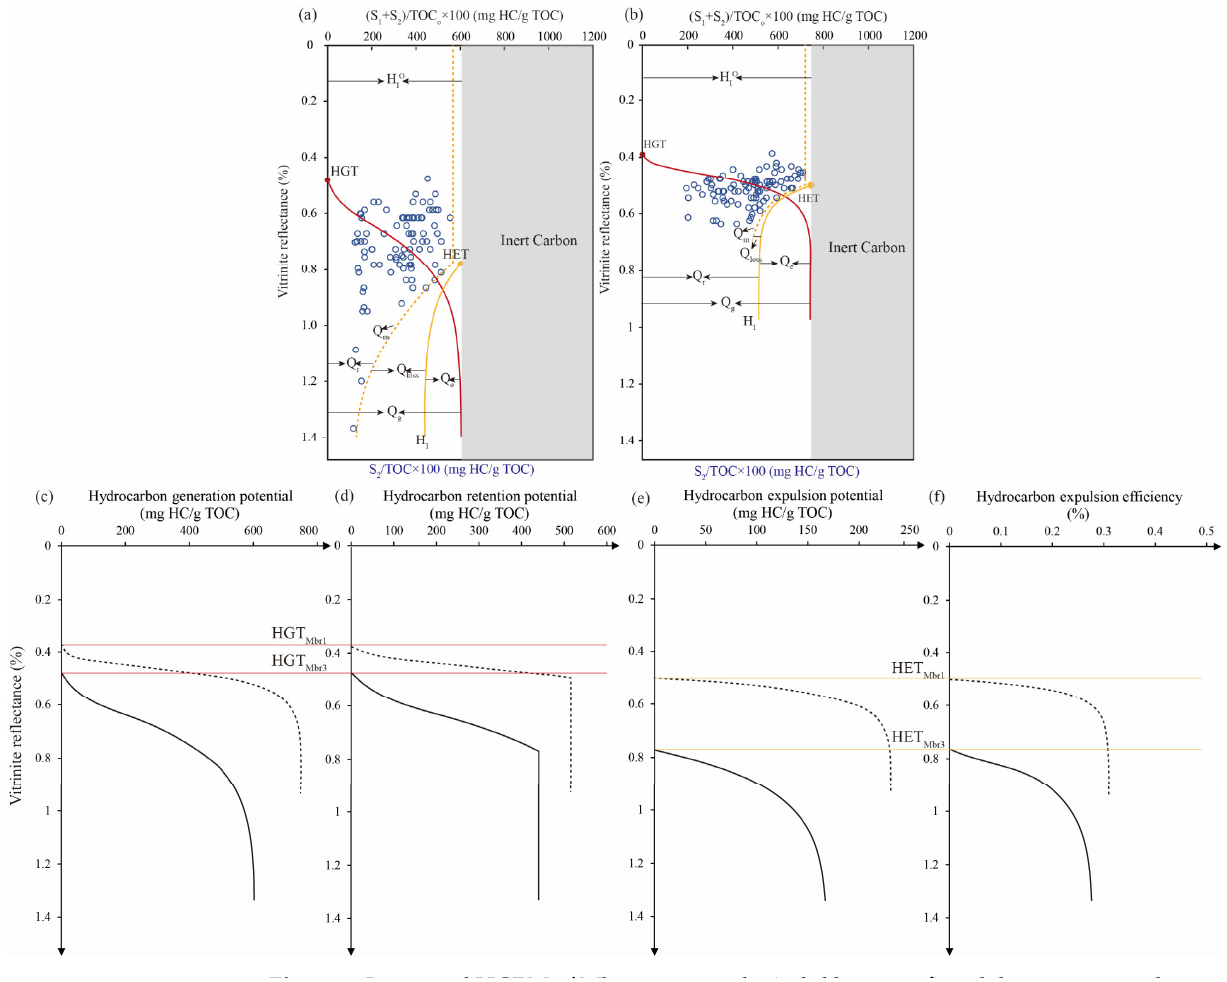
Figure 9. Improved HGPM of Mbr 3 source rocks (solid line in c – f ) and the comparison between Mbr 1 HGPM (red lines in c – d represent HGTs of Mbr 1 and Mbr 3 respectively, as explanatory notes on red lines; yellow lines in e – f represent HETs of Mbr 1 and Mbr 3 respectively). ( a ) establishment of improved HPGM of Mbr 3 source rock; ( b ) establishment of improved HPGM of Mbr 1 source